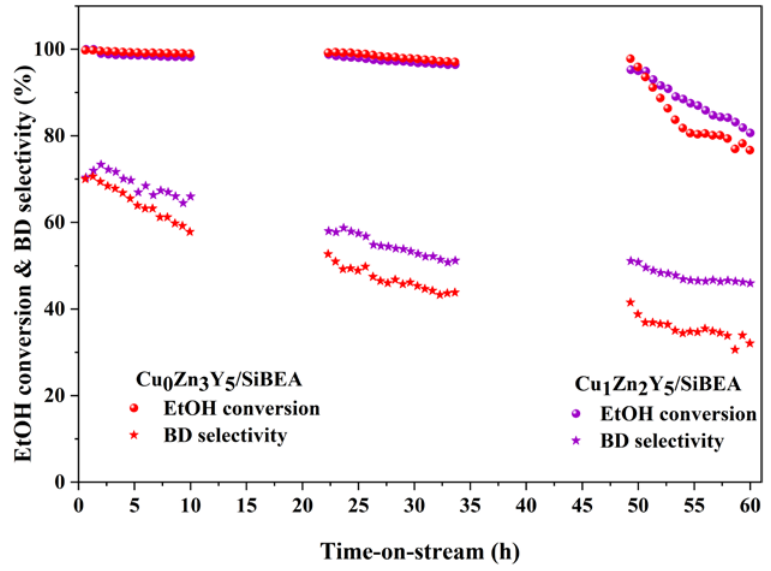
Figure 8. Stability test of Cu 0 Zn 3 Y 5 /SiBEA and Cu 1 Zn 2 Y 5 /SiBEA catalyst. ETB reaction conditions: T = 375 °C; WHSV = 1 h −1 ; TOS = 60 h. Table 5. The carbon deposition distribution of spent catalysts by